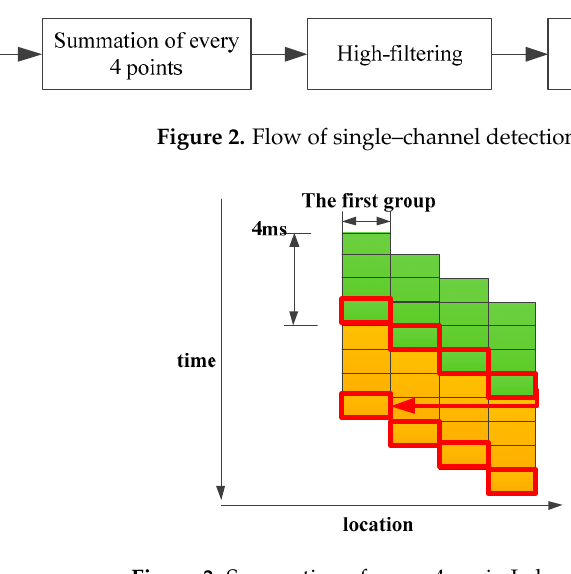
Figure 3. Summation of every 4 ms in I-channel.